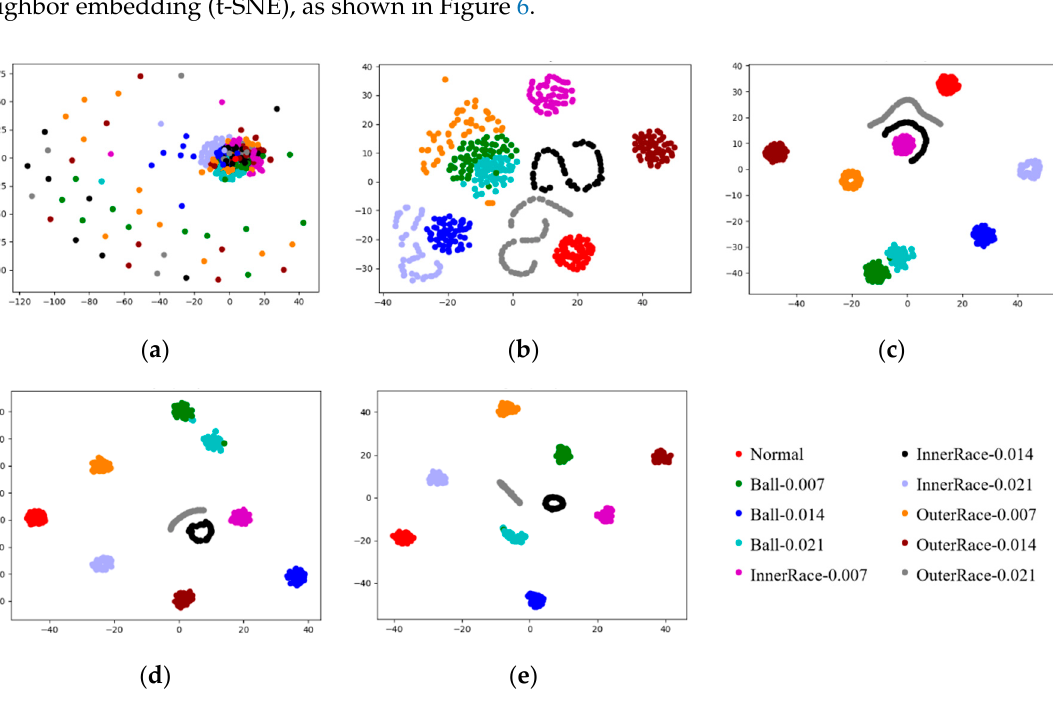
Figure 6. Visualization of all the samples of dataset A in each layer of WMSCCN after t-distributed stochastic neighbor embedding (t-SNE) dimensionality reduction. ( a ) Visualization of all the samples of dataset A in conv1 layer after t-SNE. ( b ) Visualization of all the samples of dataset A in conv2 layer after t-SNE. ( c ) Visualization of all the samples of dataset A in the multi-scale convolutional layer after t-SNE. ( d ) Visualization of all the samples of dataset A in the primary capsule layer after t-SNE. ( e ) Visualization of all the samples of dataset A in the digit capsule layer after t-SNE.